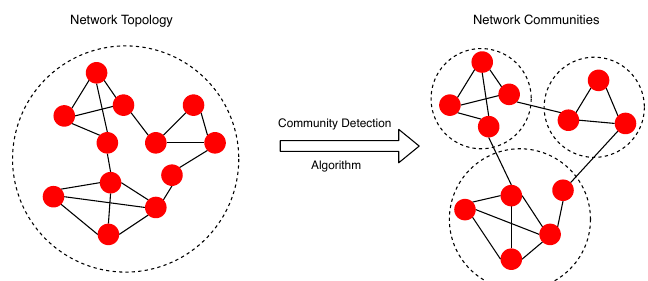
Figure 1. Illustration of community detection and graph partitioning process: A good solution (RHS) has a high number of links between members of the same community and a low number of links to other